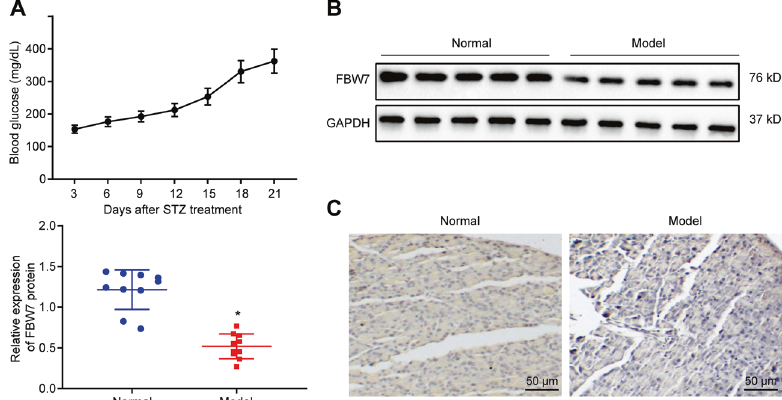
Fig. 1 FBW7 is under-expressed in the T1D mouse model. A The blood glucose level in the mouse model. B Western blot results of FBW7 expression in islets from T1D mice ( n = 10) and control mice ( n = 10), * p < 0.05, vs. the normal group. C Representative images of IHC for FBW7 expression in islets from T1D mice and control mice with arrows pointing at cells positive for FBW7 (bar = 25 μ m). Measurement data are presented. Data comparisons between two groups were analyzed by unpaired t -test. Sta t istical analysis in relation to time-based measurements within each group was realized using repeated-measures